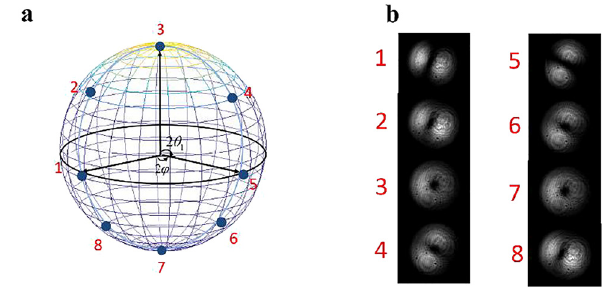
Figure 3: (a) Equivalent first-order Poincaré sphere combing with Jones vectors representation. (b) The mode patterns of speci fi c points in a period on this sphere surface.